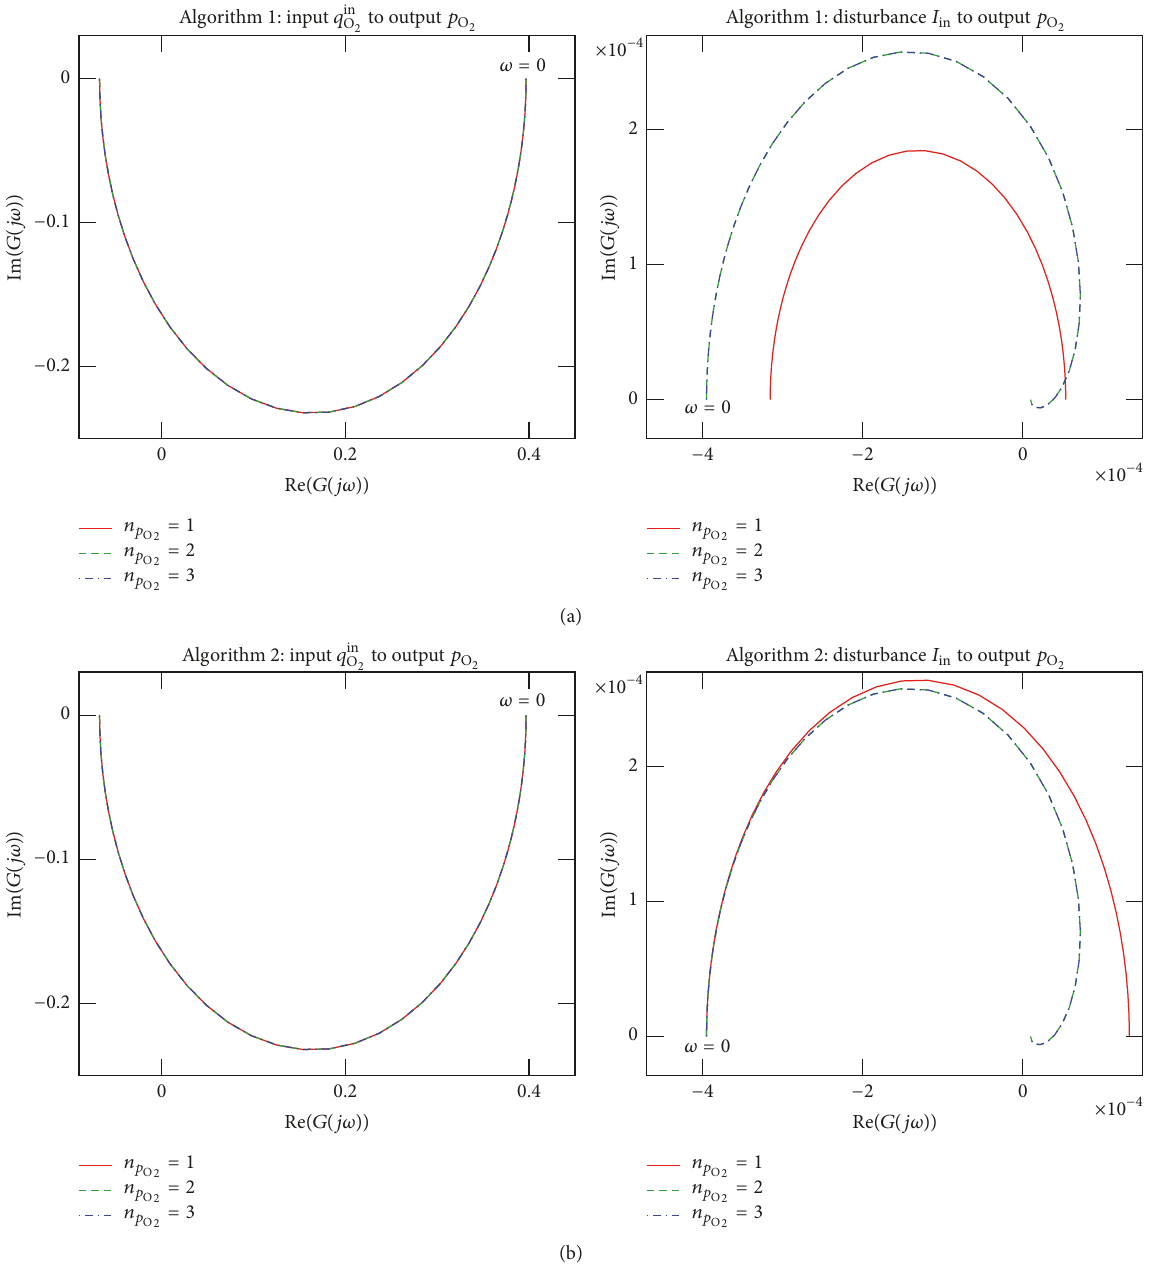
= 1, 2 ) and full order ( 𝑛 = 3 ): reduction algorithm 1 𝑝 O 2 O 2